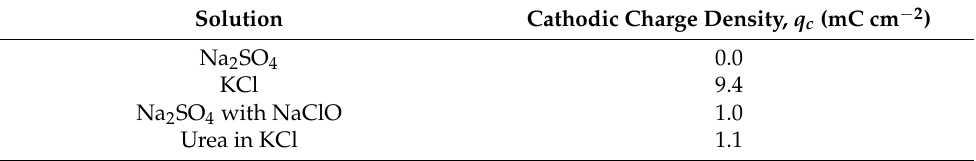
Table 3. Collected q c -values obtained at the range of 0.8–1.1 V vs. Ag/AgCl for DSA Ti/RuO 2 -TiO 2 - SnO 2 (50:40:10 atom.